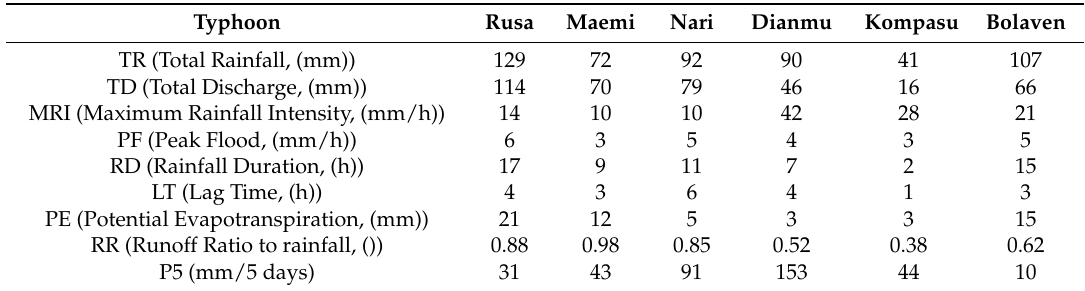
Table 3. Characteristics of the events at C4